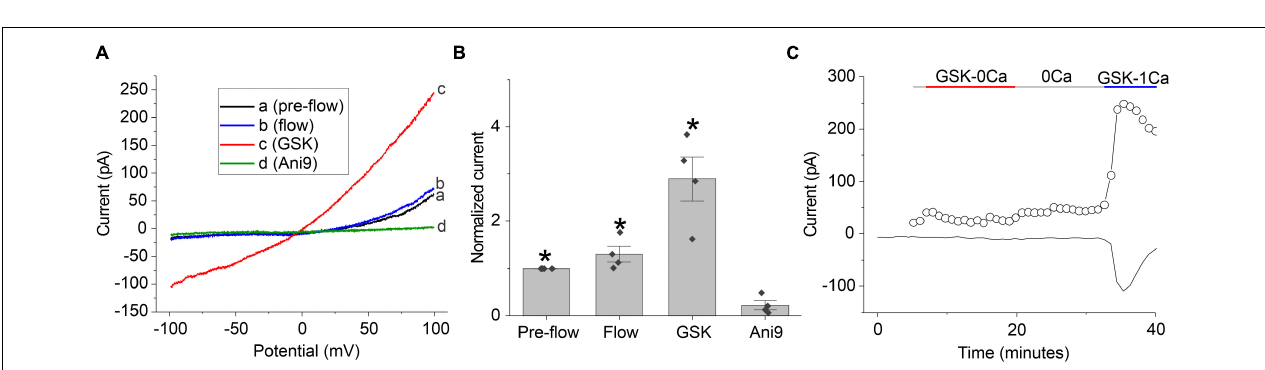
FIGURE 5 | TRPV4 agonist-induced current response in dissociated lens cells. (A) Representative experiment showing the effect of 30 nM GSK (red bar) on the amplitude of the chloride current measured at + 100 mV (open circles) or –60 mV (solid line) in a lens cell. NMDG-Cl bath and pipette solutions were used to prevent contamination of the chloride current by non-selective cation currents. Holding potential was –60 mV. Ramps from –100 to + 100 mV with a duration of 2 s were applied every 55 s. (B) Currents measured in response to ramps at points indicated by a, b, c, and d in panel (A) . (C) Bar graph with individual data points ( n = 6) indicating the effect of 30 nM GSK on the amplitude of the chloride current at +100 mV normalized to the value of the current at +100 mV measured pre-flow. Significant differences (*) are relative to the GSK condition.